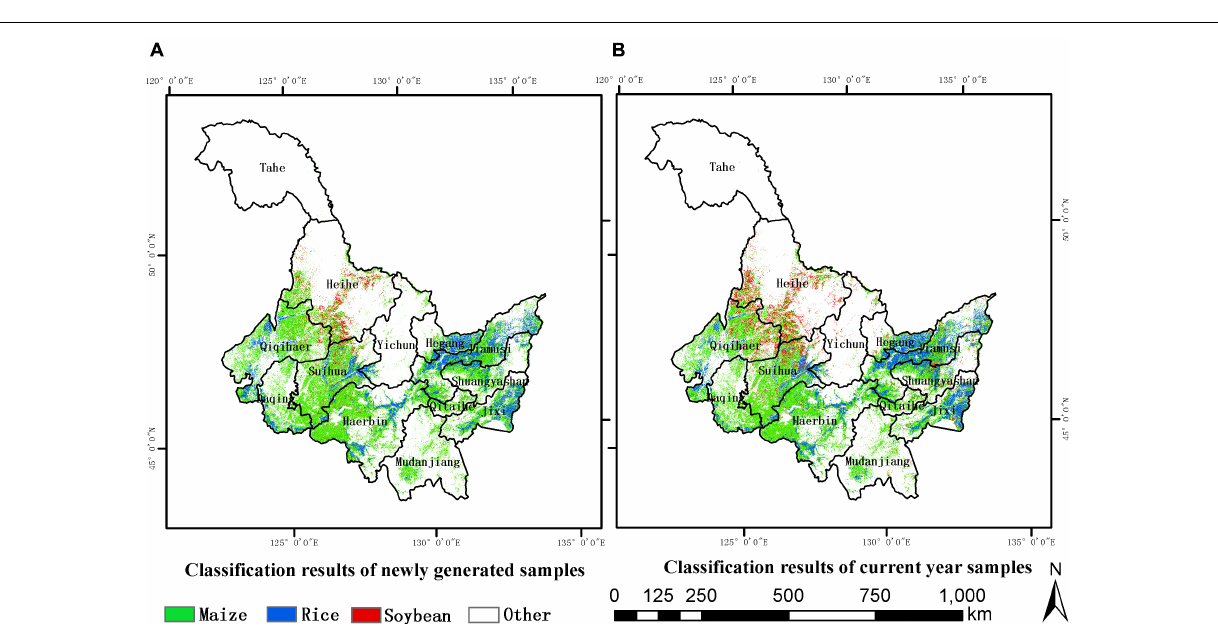
Frontiers in Plant Science |